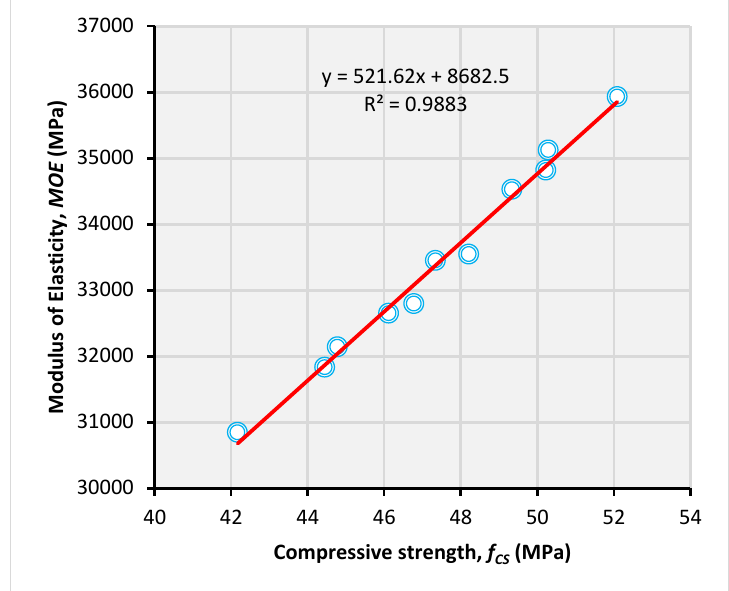
Figure 10. Correlation between f CS and MOE .